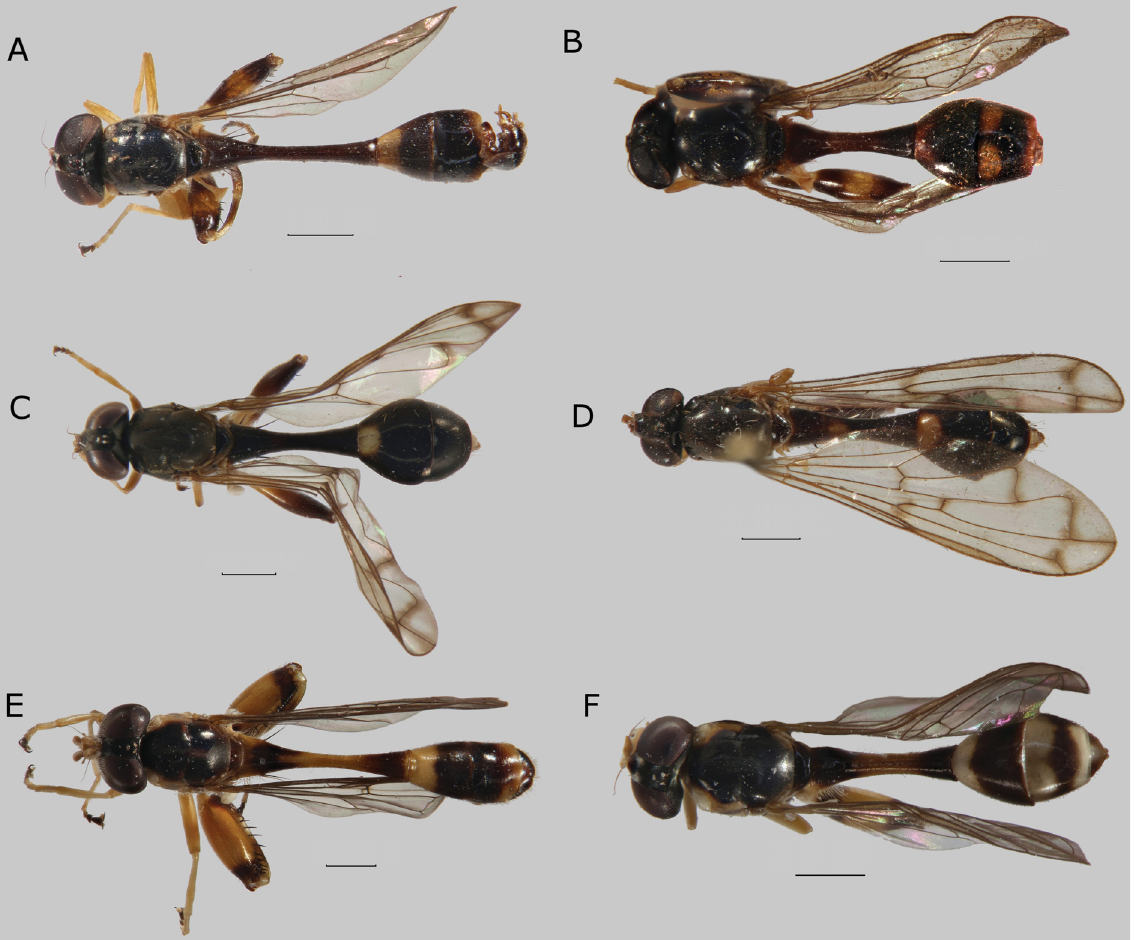
Fig. 25. Habitus, dorsal view. A . Sphegina (Asiosphegina) bracon sp. nov., paratype, ♂ ,